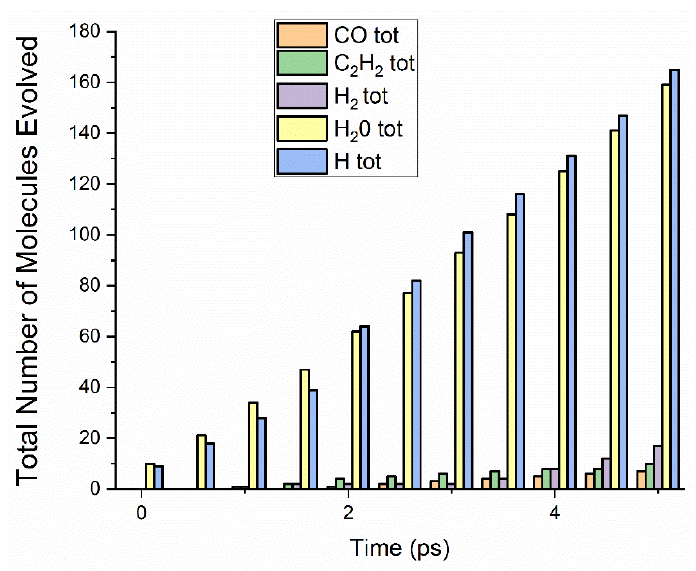
Figure 4. Evolution of small molecule species versus RMD simulation time.